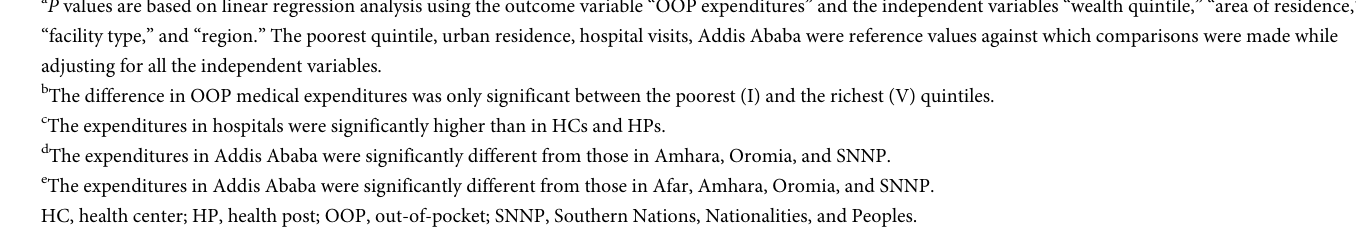
quintile: The richest spent 4 times more compared with the poorest ($3,639 versus $907). Food expenditures accounted for 68% of total expenditures for the poorest (48% for the richest). For outpatient care, 0 � 2% and 0 � 3% incurred CHE with a 10% threshold of annual expenditures